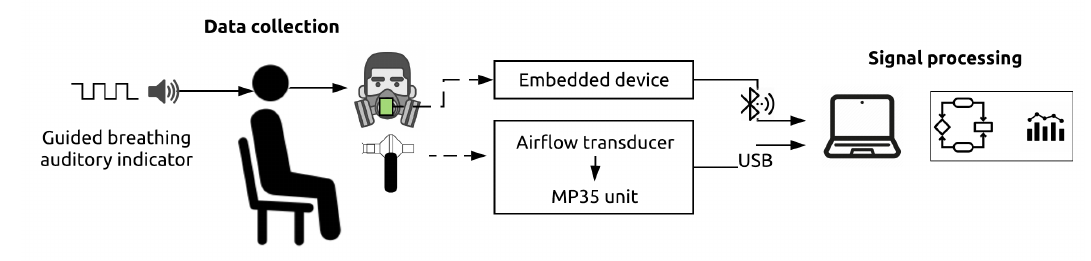
Figure 6. Schematic diagram of experimental setup for data collection process.